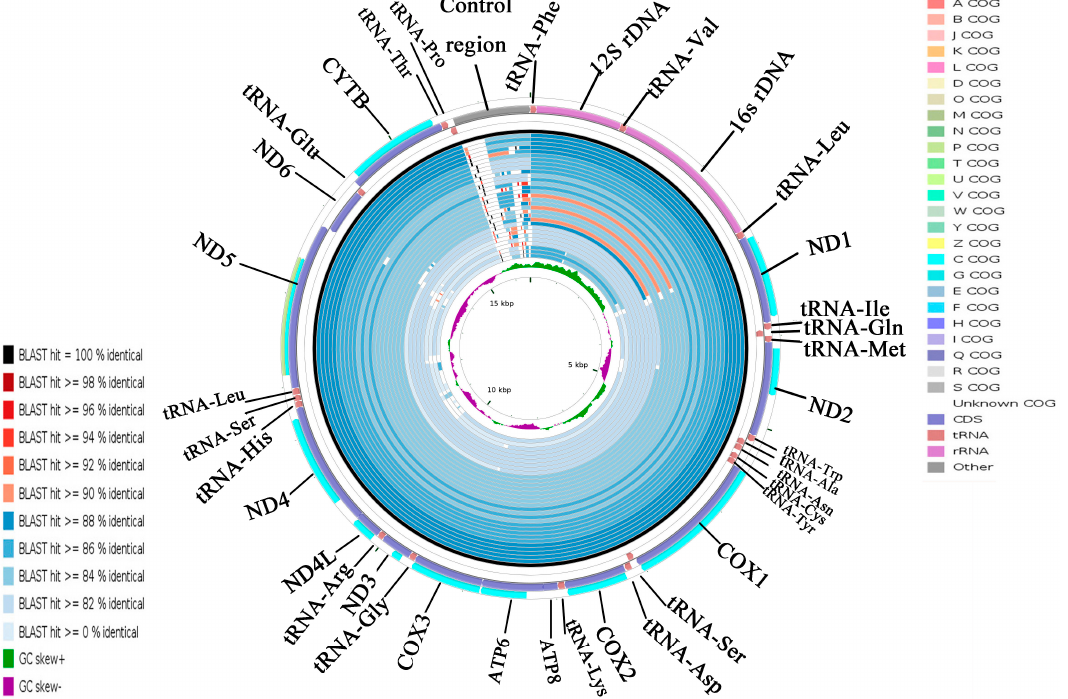
Figure 6. Graphical map of the blast results showing the nucleotide identity between the complete mitogenomes of Alectis indicus and 31 other Carangidae using the CGView comparison tool (CCT). CCT arranges blast results in order so that sequences that are most similar to the reference ( A. indicus ) are placed closer to the outer edge of the map. Note: Clusters of orthologous groups of proteins (COG), gene region, blast identity, and AT-skew are shown from outside to inside. The species from outside to inside are as follows: Alectis indicus , Alectis ciliaris , Uraspis secunda , Uraspis helvola , Parastromateus niger , Carangoides armatus , Carangoides malabaricus , Trachurus trachurus , Trachurus japonicus , Megalaspis cordyla , Caranx melampygus , Decapterus macrosoma , Decapterus tabl , Decapterus macarellus , Caranx tille , Alepes kleinii , Decapterus maruadsi , Alepes djedaba , Atule mate , Caranx ignobilis , Selaroides leptolepis , Selar crumenophthalmus , Kaiwarinus equula , Elagatis bipinnulata , Seriola rivoliana , Seriola quinqueradiata , Seriola dumerili , Seriolina nigrofasciata , Seriola lalandi , Trachinotus blochii , Trachinotus carolinus , and Trachinotus ovatus .